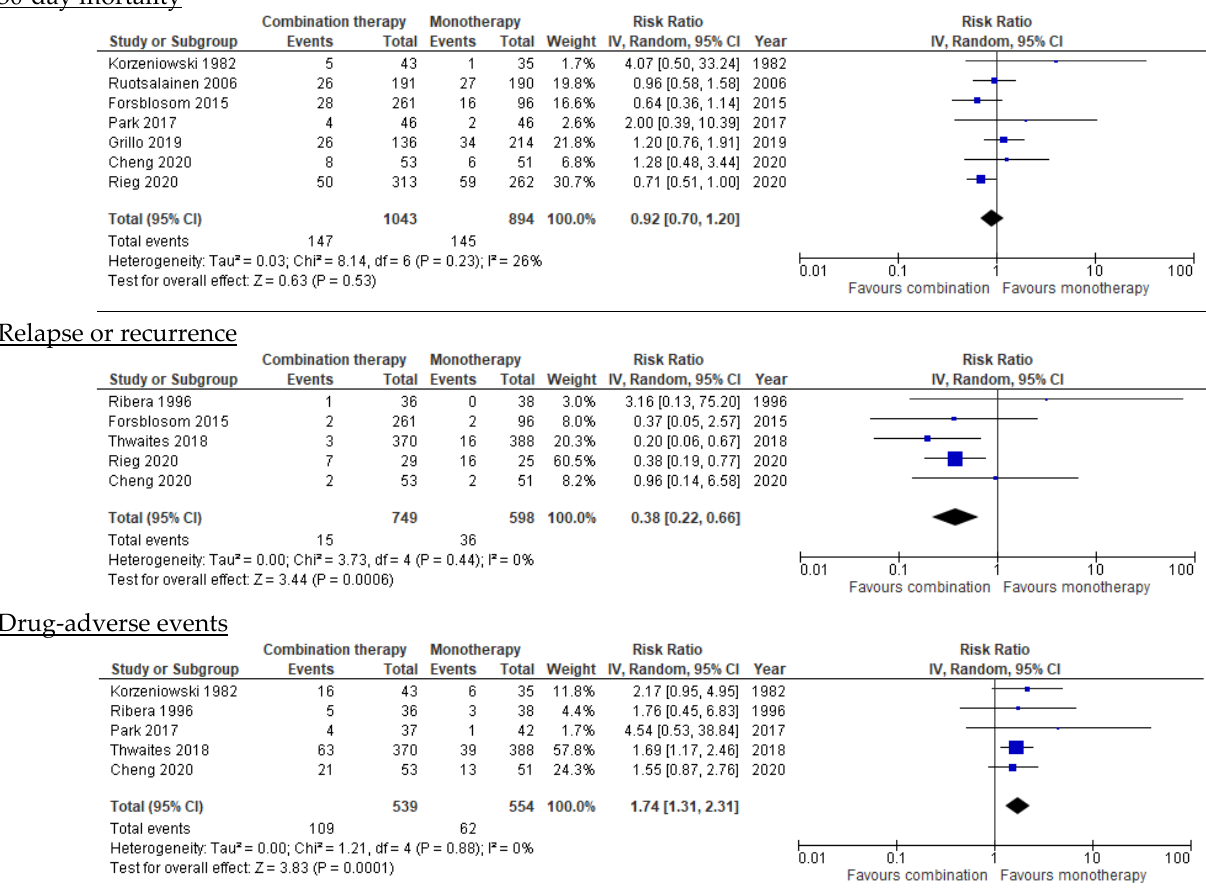
Figure 2. Effectiveness of combination therapy on main outcomes. Subgroup analyses performed separately for RCTs and observational studies did not yield different results, but heterogeneity was moderate-high among observational studies (30-day mortality: I 2 = 42%; 90-day mortality: I 2 = 68%) (Table 2). To investigate causes of heterogeneity, we pooled observational studies that were adjusted for confounding factors and RCTs with well-balanced characteristics between study groups. The hetero- geneity decreased and results were consistent with the main findings, with no reductions in 30- and 90-day mortality with combination therapy (pRR 1.04, 95% CI, 0.67–1.60; I 2 = 0% and pRR 0.96, 95% CI, 0.78–1.19; I 2 = 13%, respectively).